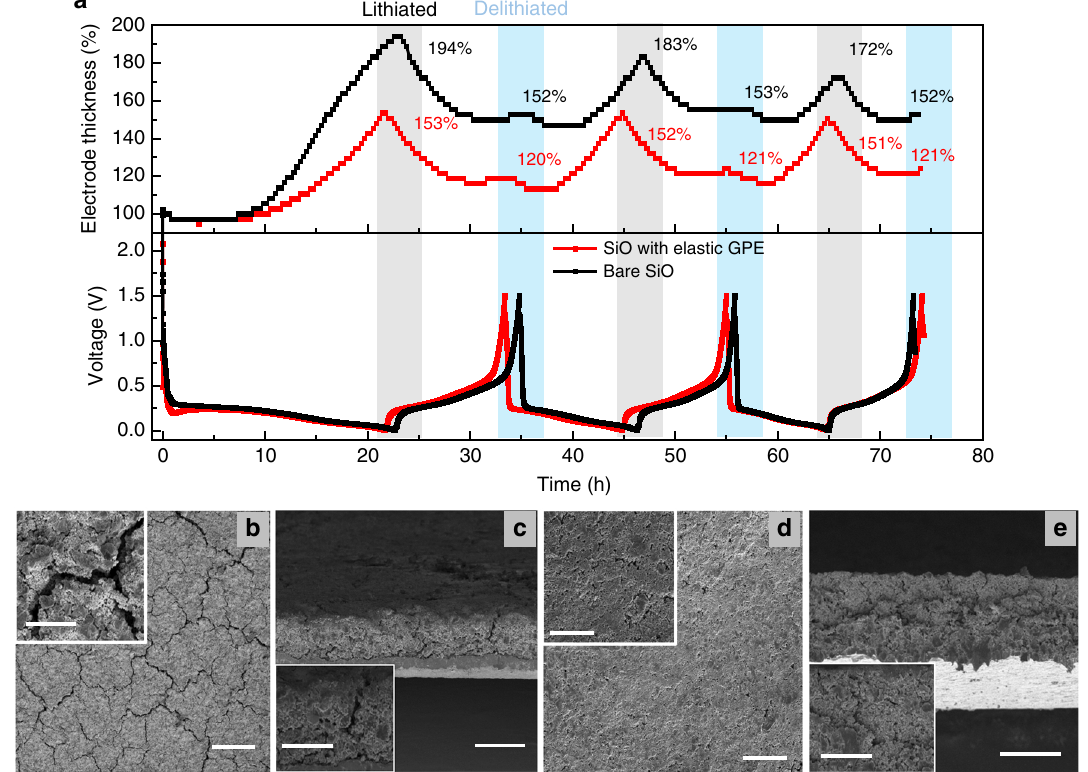
Fig. 3 Characterization of the SiO electrode with an elastic GPE. a In situ measurement of thickness evolution of a control SiO electrode and a SiO electrode with the elastic GPE in the initial three lithiation/delithiation cycles at a current density of 0.3 mA cm − 2 between 0.01 and 1.5 V. The mass loading of SiO electrodes is 3.7 mg cm − 2 and the copolymer amount is 0.4 mg cm − 2 . b , c Top-view ( b ) and cross-sectional ( c ) SEM images of the control SiO electrode after 10 cycles. d , e Top-view ( d ) and cross-sectional ( e ) SEM images of the SiO electrode with the elastic GPE after 10 cycles. Scale bars: 100 μ m ( b , d ), 20 μ m (insets in b , d ), 50 μ m ( c , e ), 20 μ m (insets in c , e